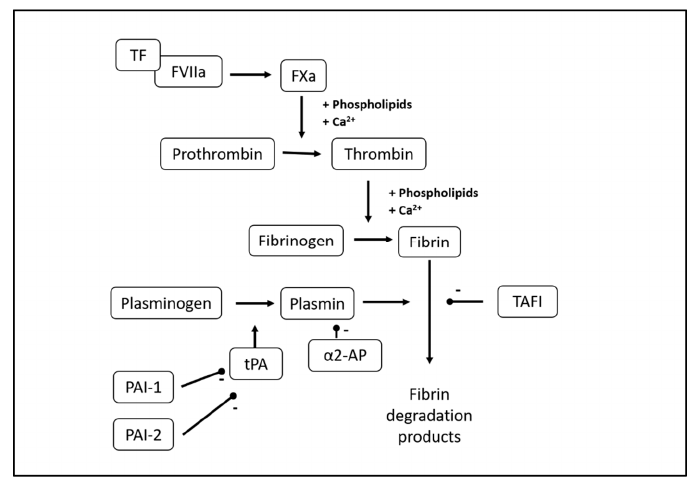
Figure 1. Overview of the fibrinolytic process. α 2-AP, α 2-antiplasmin; F, coagulation factor; PAI, plasminogen activator inhibitor; PL, phospholipids; TAFI, thrombin-activatable fibrinolysis inhibitor; TF, tissue factor; tPA, tissue plasminogen activator.